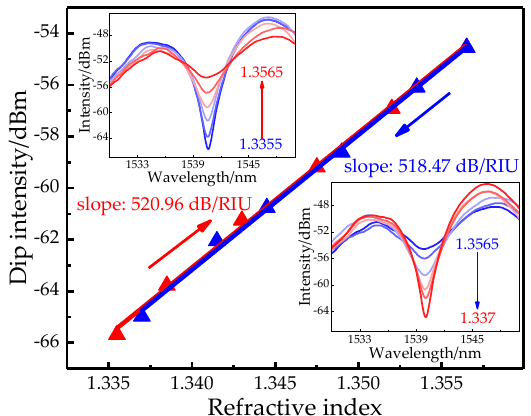
Figure 5. Intensity responses with the rising and reducing of SRI. Insets: transmission spectra.